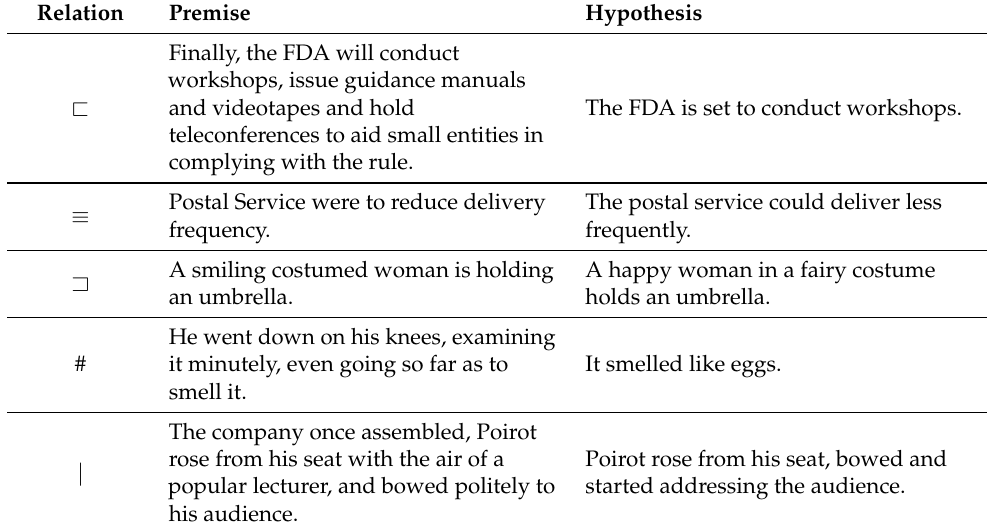
Table 4. Sample “entailment” and “neutral” pairs from